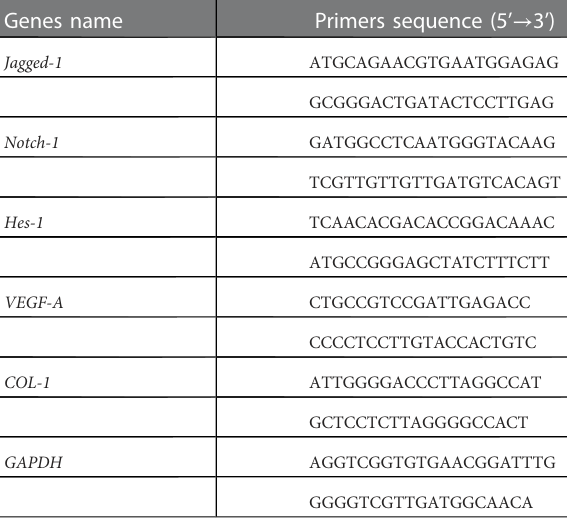
calculations. The relative expression value was calculated with TABLE 1 Primer sequences for quantitative reverse-transcription